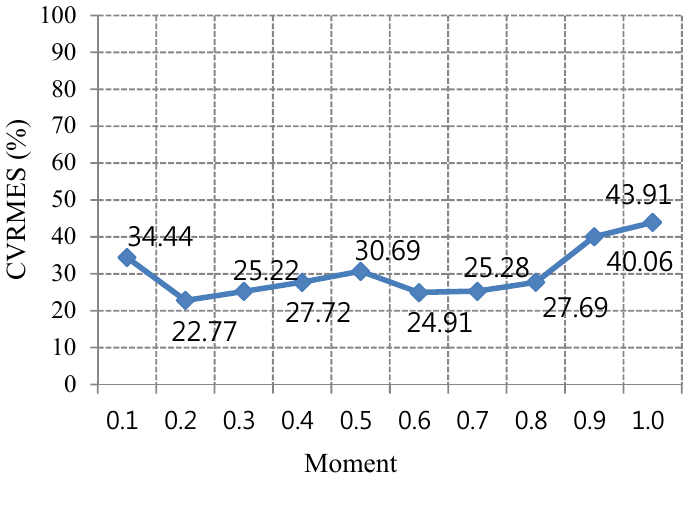
Figure 8. MBE by a different moment.